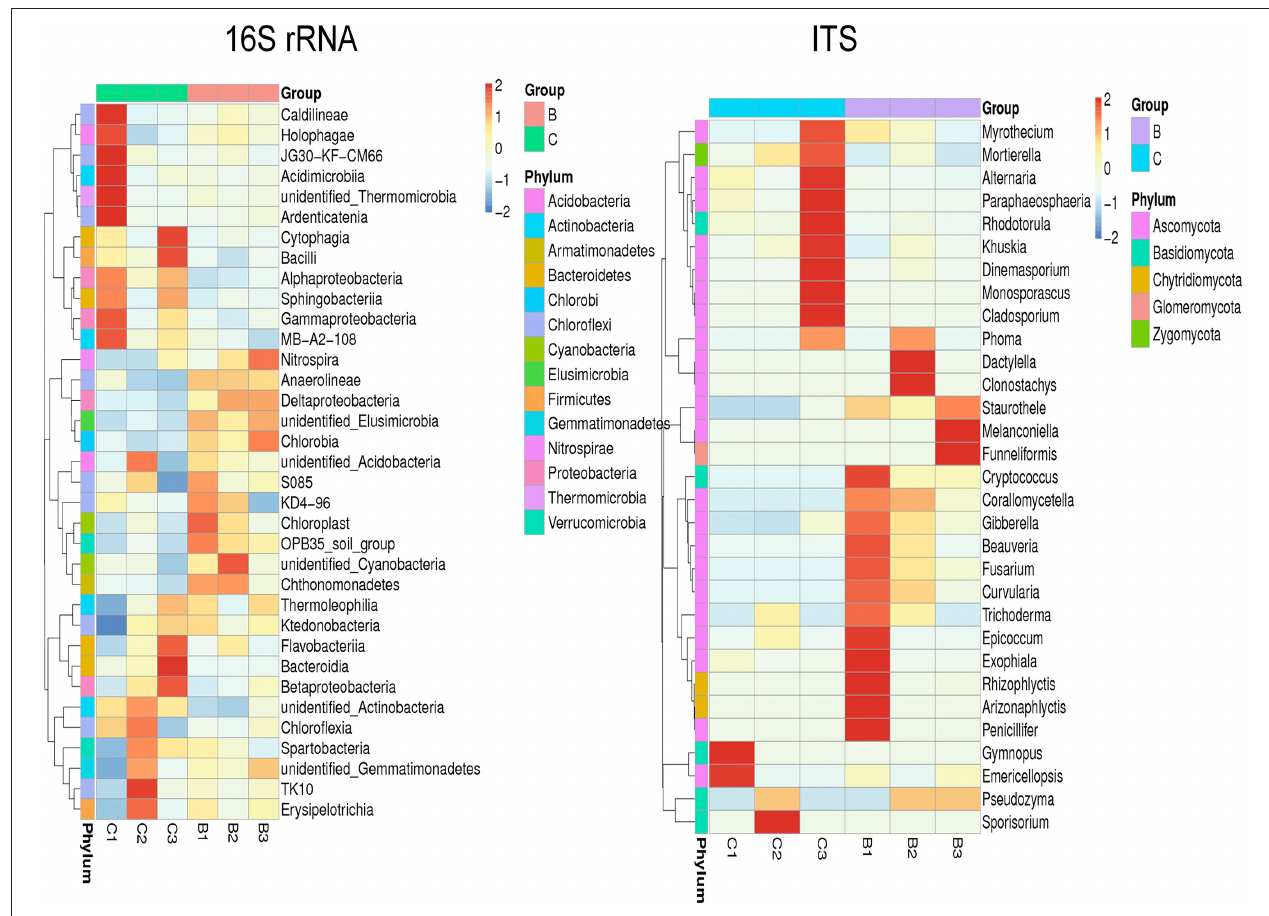
FIGURE 6 | Clustering heat map at genus level of 16S rRNA and ITS gene B: Intercrop, C: Monoculture.